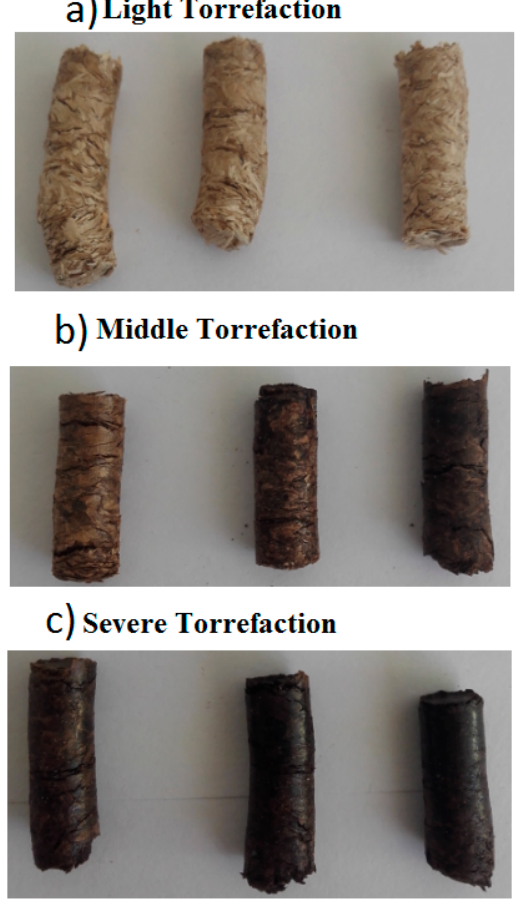
Figure 1. Torrefied pellets at different temperatures and times of five types of biomass from woody tropical species: ( a ) light torrefaction; ( b ) Middle torrefaction; ( c ) Severe torrefaction.